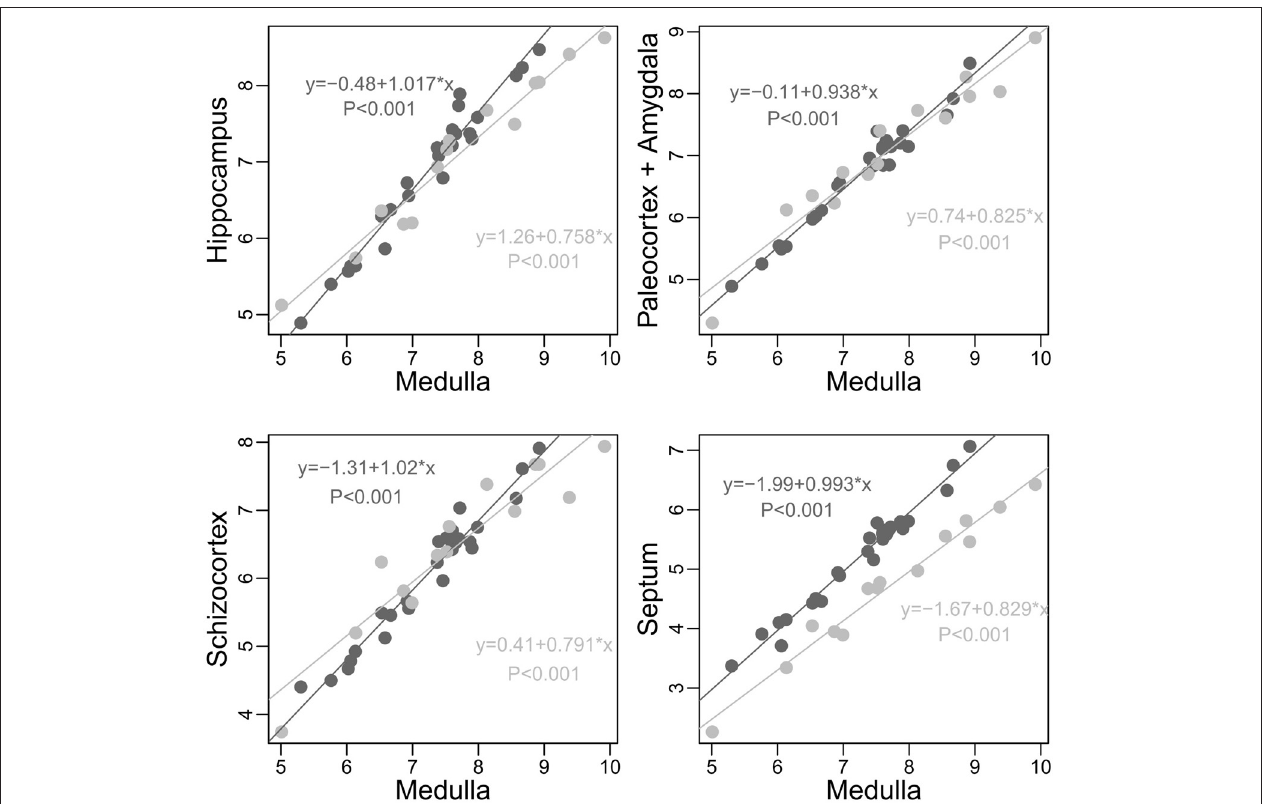
FIGURE 4 | Scaling of limbic structures onto medulla (log scale) in carnivores (light gray) and simians (dark gray). To strengthen the point, pinnipeds species are not included in this analysis (pinnipeds apparently have smaller hippocampus, paleocortex, and amygdala than fissipeds of similar medulla size, but similar septum and schizocortex size, unpublished analysis). In no cases does simians as a group have smaller limbic structures than predicted by the size of their medulla when compared to carnivores